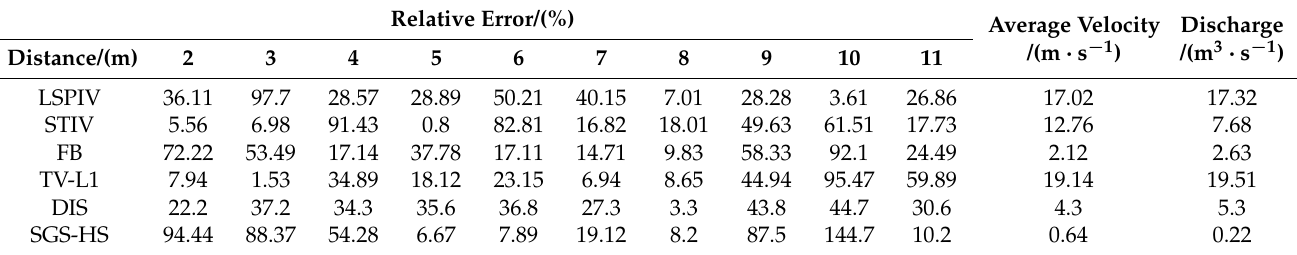
Table 4. Relative errors of the velocity measurement results of the six algorithms. Relative Error/(%)